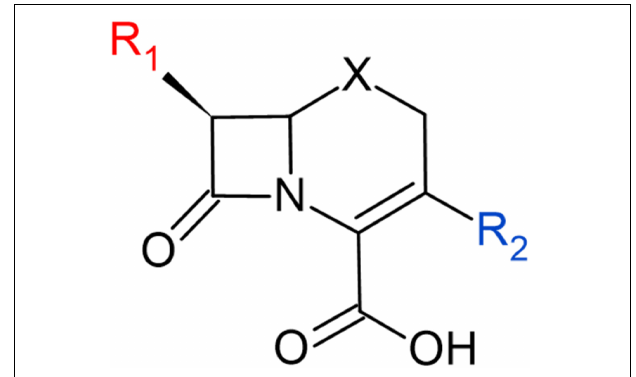
FIGURE 8 | Structural representation of R 1 and R 2 chemical groups in cephem